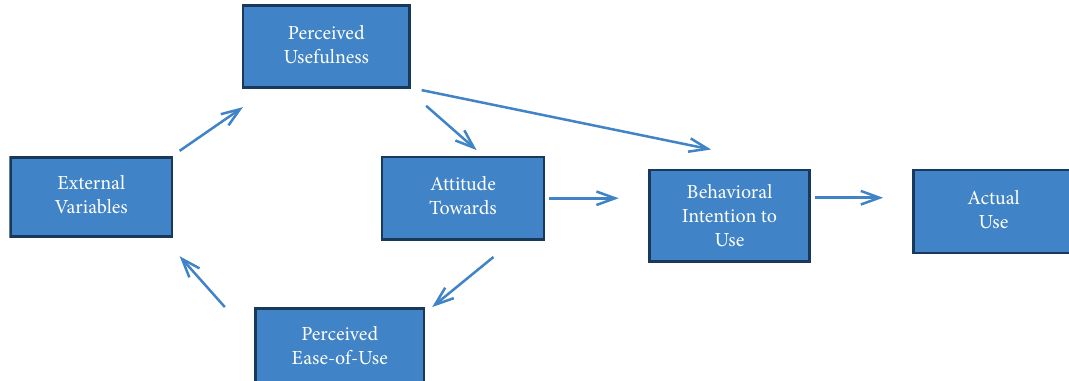
Figure 2: Technology acceptance model in education.